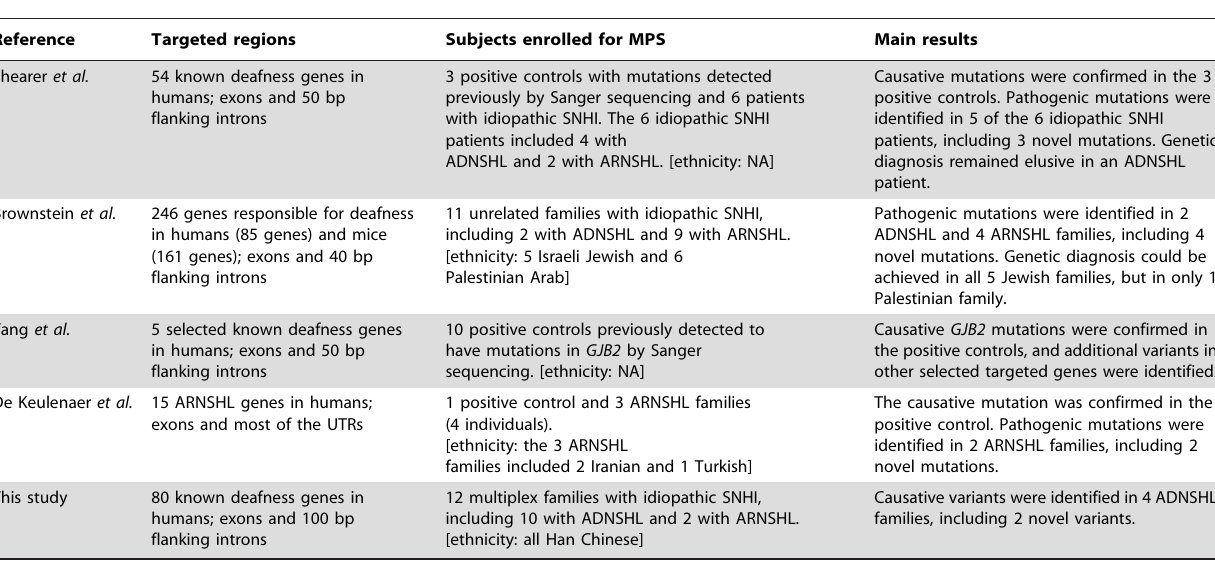
Table 3. Summary of the 5 Series Investigating the Diagnostic Utility of